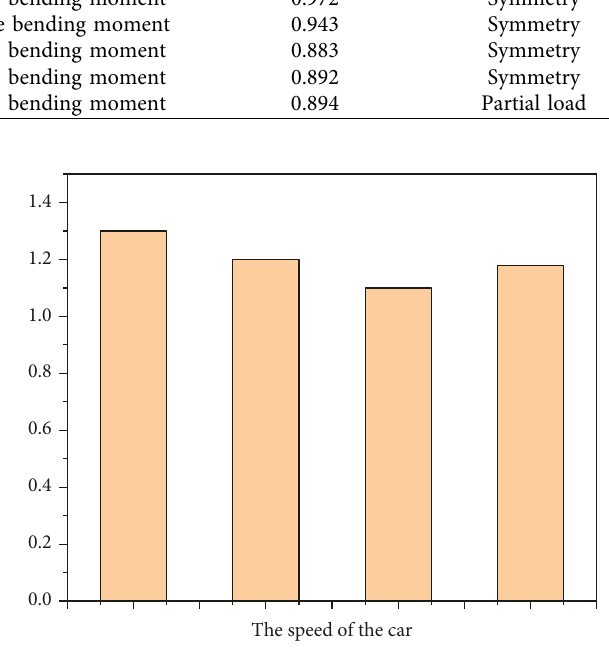
Figure 5: Bridge damping ratio at different vehicle